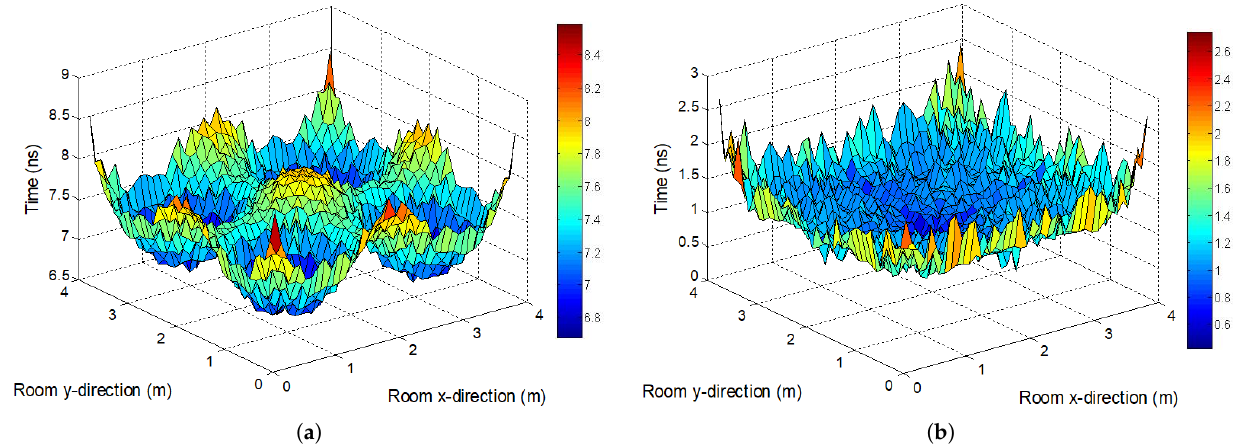
Figure 6. Simulated temporal dispersion of the impulse responses throughout the room: ( a ) Mean delay. ( b ) Delay spread.